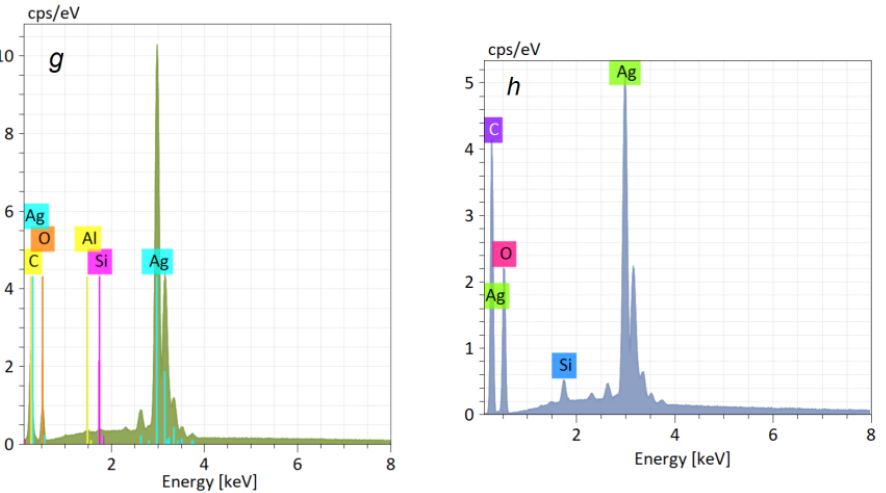
Figure 6. Elemental distribution of C, O, Ag for Ag NPs/BCF ( a , c , e ) and Ag NPs/BCS ( b , d , f ) and energy dispersive X-ray spectra of Ag NPs/BCF: C—45.4 at.%; O—39.9 at.%; Si—0.6 at.%; Ag—13.6 at. %; and Al—0.5 at. % ( g ) and Ag NPs/SBCB: C—40.8 at.%; O—46.2 at.%; Si—1.3 at.%; Ag—11.7 at. % ( h ) nanocomposites.